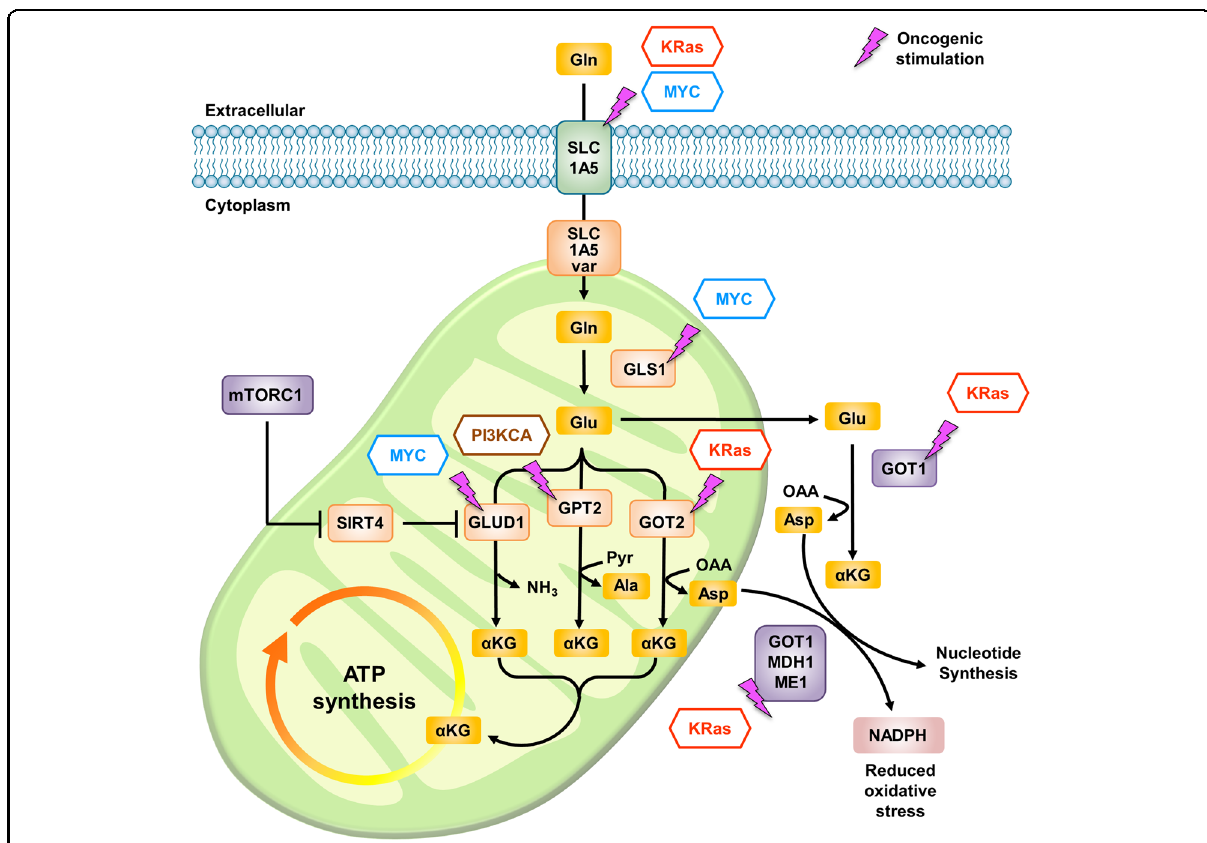
Fig. 7 Oncogenic control of glutamine metabolism. Oncogenes such as MYC, K-Ras, and PI3KCA modulate cancer metabolic reprogramming, favoring cancer cell growth and survival partially via the promotion of glutamine metabolism. Glutamine uptake is enhanced in MYC- and K-Ras- driven cells in which the expression of the glutamine transporter SLC1A5 is upregulated. Deamination of glutamine to form glutamate in mitochondria is enhanced by MYC-mediated upregulation of GLS1. Conversion of glutamate into α -KG is mediated by GLUD1 or aminotransferases such as GOT1/2 and GPT2. The expression of these enzymes is upregulated in cancer cells with MYC-driven, K-Ras-driven, and PI3KCA-driven signaling activation. Gln glutamine, Glu glutamate, Ala alanine, Asp aspartate, α -KG α -ketoglutarate, GLS1 glutaminase 1, GLUD1 glutamate dehydrogenase 1, GOT1/2 glutamic-oxaloacetic transaminase 1/2, GPT1/2 glutamic-pyruvate transaminase 1/2, MDH1 malate dehydrogenase 1, ME1 malic enzyme